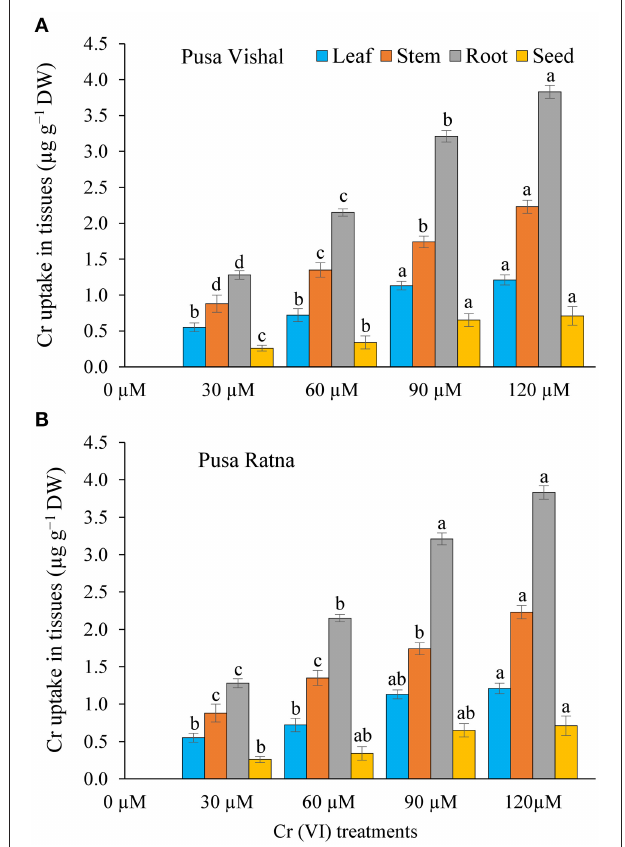
FIGURE 12 | Accumulation of chromium (Cr [VI]) ( µ g · g − 1 dry weight [DW]) of organs viz. leaves, stems, roots, and seeds of two Mungbean cultivars, (A) Pusa Vishal (PV) and (B) Pusa Ratna (PR) in pot conditions under different Cr (VI) treatments. Mean values of three replicates are shown; error bar ( ± standard error [SE]). Mean values with the same letter don’t have significant difference at p ≤ 0.05 according to the Least Significant Difference test (LSD 0.05